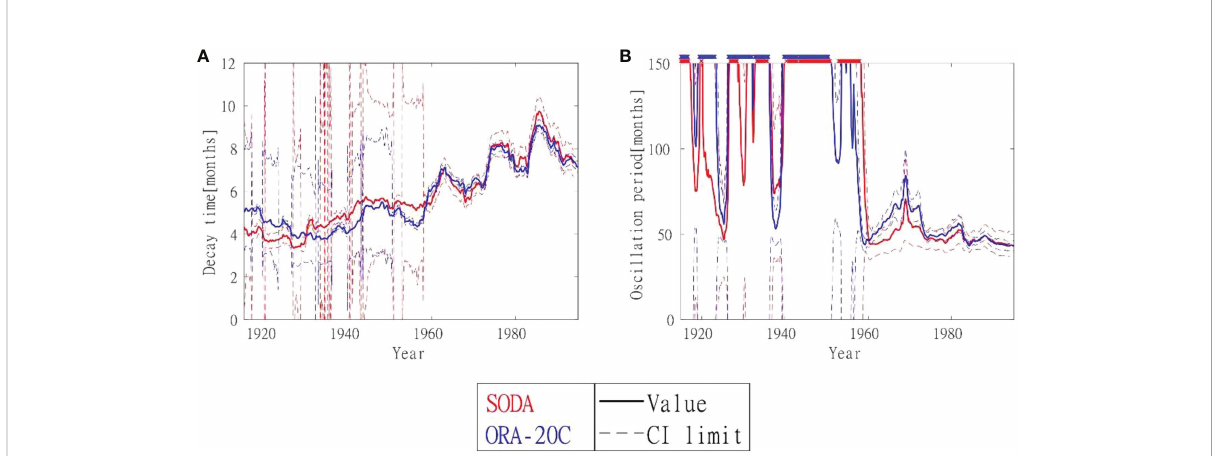
FIGURE 7 Decay times (A) and oscillation period (B) for the ReOsc+ model for the Atlantic-Paci fi c SST system (Eq. 8 fi tted as explained in Section 2.3) in the period 1900-2008 for SODA (red) and in the period 1900-2009 for ORA-20C(blue) reanalysis. Each point of the fi gure considers a time window of 30 years, and the represented year in the horizontal axis is the mean value of that interval. Solid lines represent the value of the characteristic times, and dashed lines show the (1-standard-deviation) con fi dence intervals. (They were computed as described in Section 3 and Supplementary Appendix D, respectively). In the right panel (red for SODA and blue for ORA-20C), crosses denote windows with a non- oscillating regime (i.e., we cannot represent oscillation periods).